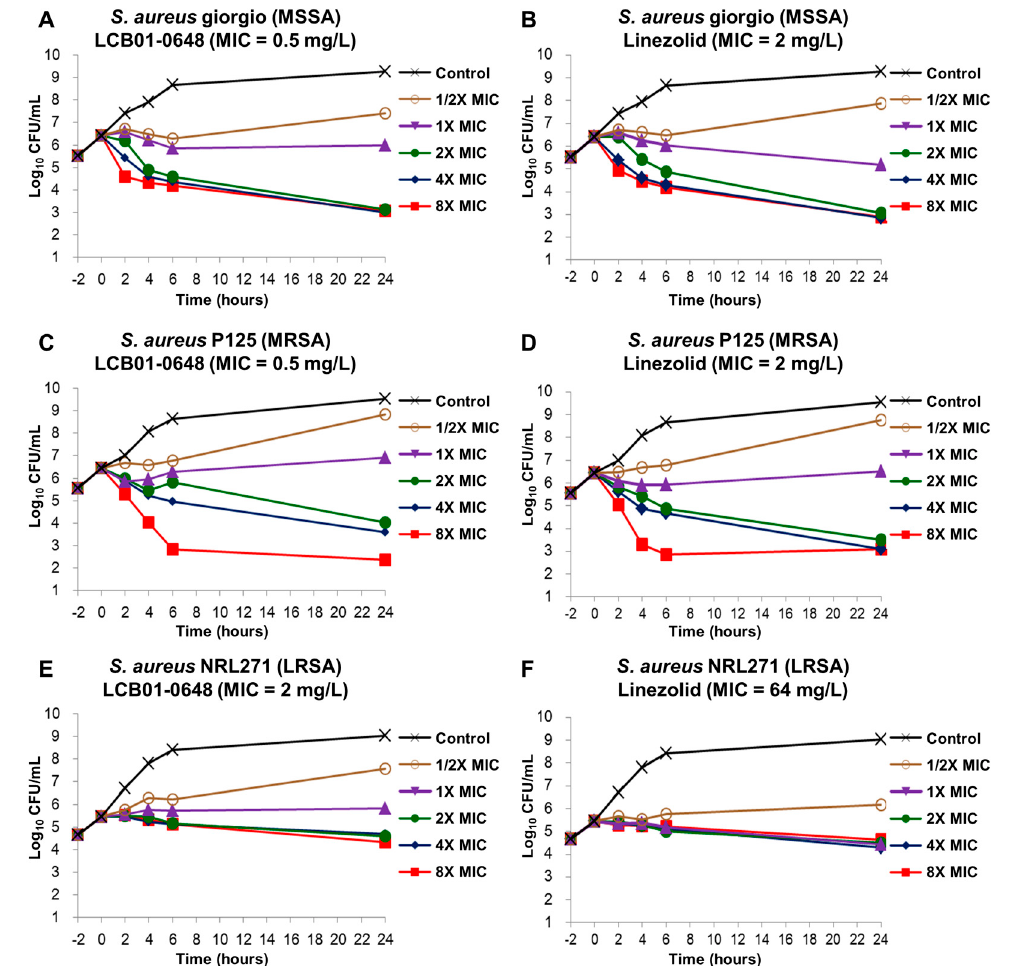
Figure 2. Time–kill curves of LCB01-0648 and linezolid against Staphylococcus aureus . S. aureus Giorgio (methicillin-susceptible S. aureus , MSSA) exposed to ( A ) LCB01-0648 or ( B ) linezolid ( B ). S. aureus P125 (methicillin-resistant S. aureus , MRSA) exposed to ( C ) LCB01-0648 or ( D ) or linezolid. ( E and F ) S. aureus NRS271 (linezolid-resistant S. aureus , LRSA) exposed to LCB01-0648.